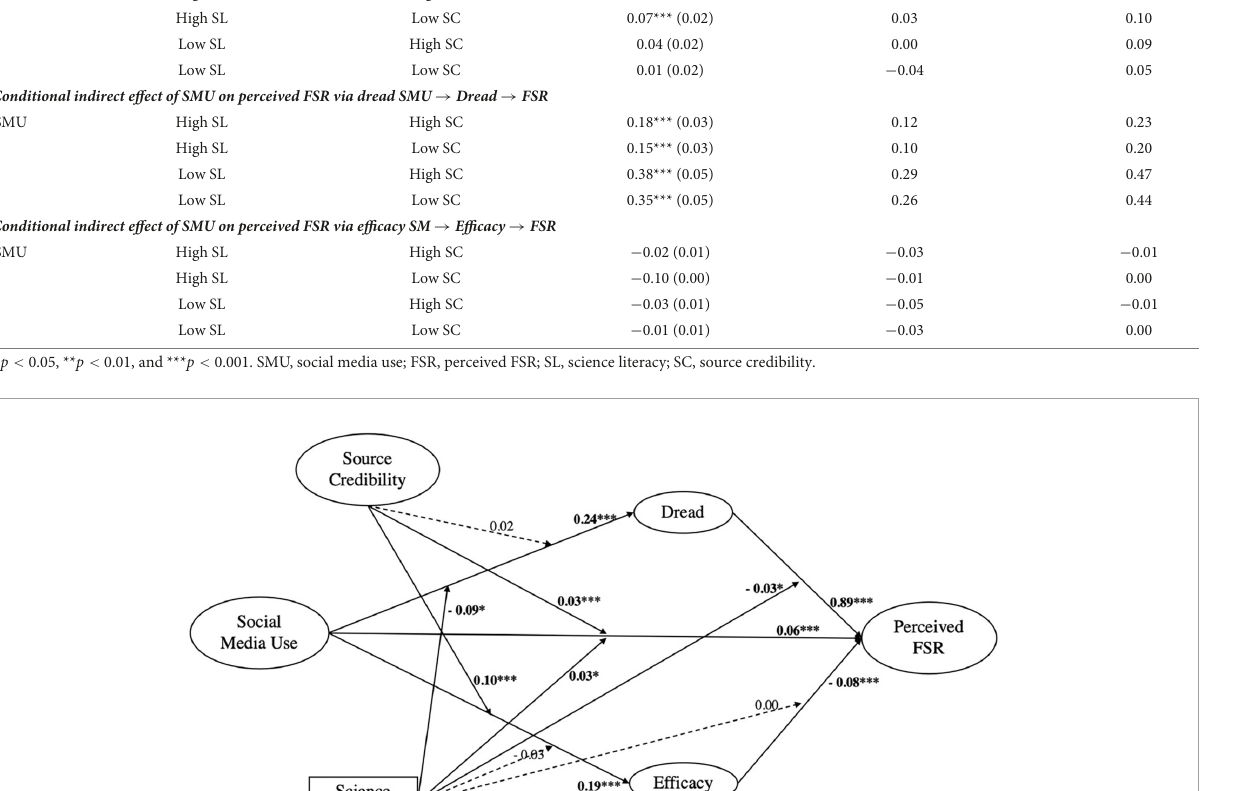
ConditionaldirecteffectofstocktickerSMUonperceivedstocktickerFSRSMU → FSR